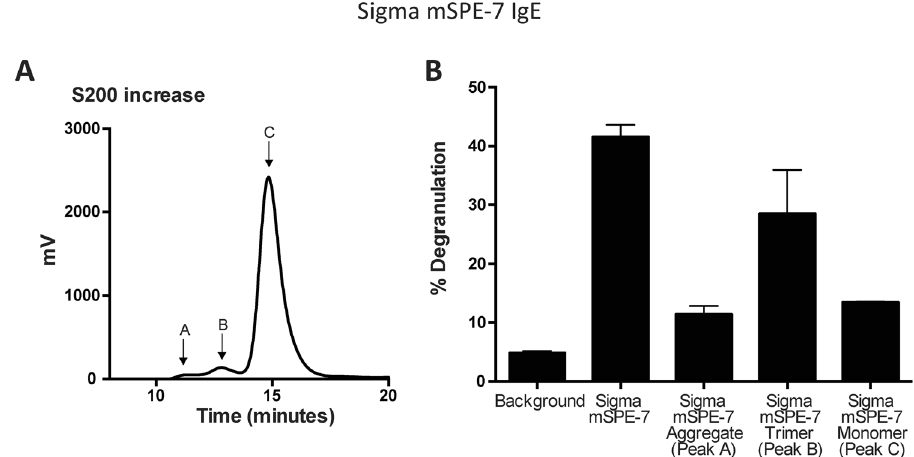
Figure 3. Improved size-exclusion chromatography resolves a previously unrecognized component in mSPE-7 IgE that has cytokinergic activity. ( A ) The superior resolution of SPE-7 IgE by Superdex 200 Increase compared to Superdex 200, resolved a component of intermediate size (Peak B) between the monomer (Peak C ) and aggregated SPE-7 IgE (Peak A). ( B ) Low levels of degranulation were induced by components A and C, compared to component B. Means of triplicate technical repeats ± SEM are